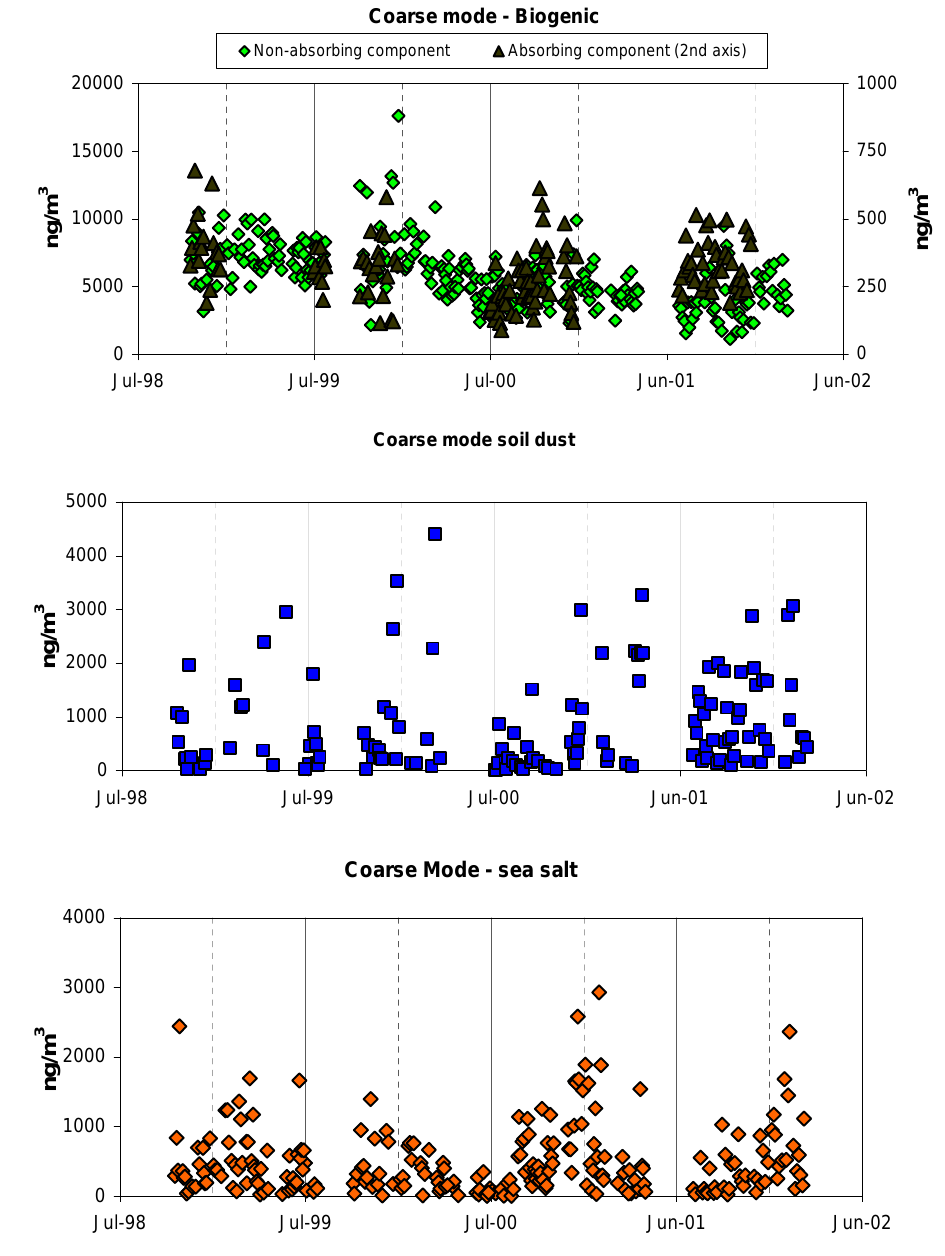
Fig. 12. The same of Fig. 11, but for coarse mode: (a) Biogenic contribution, separated in absorbing and non-absorbing components, (b) Soil dust and (c) Seasalt